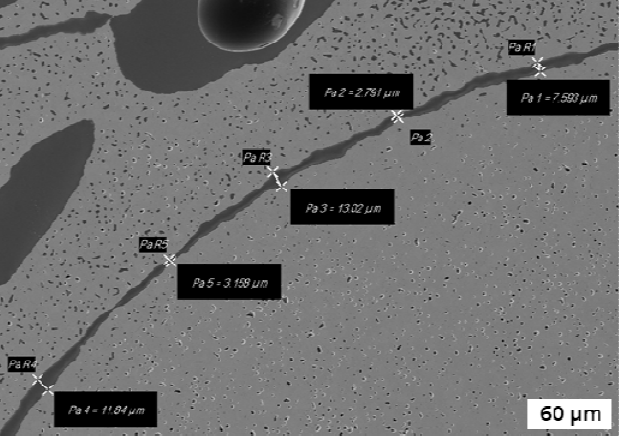
Figure 6. FESEM image: measured distance in the gap interface of VPP column and Freeze Foam.